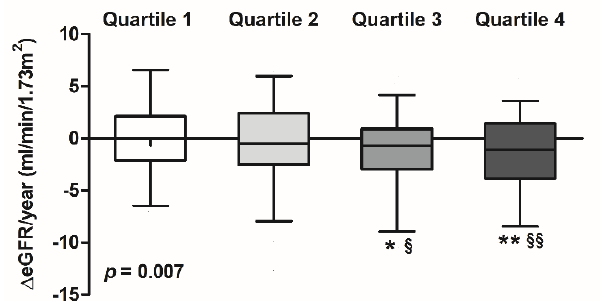
Figure 4. Decline in kidney function as measured by estimated glomerular filtration rate (eGFR) according to sex-stratified quartiles of plasma levels of group IIA secretory phospholipase A 2 (sPLA 2 -IIA). Data are shown as box plots, with the middle vertical line indicating the median, the limits of the box indicating the interquartile range, and the whiskers indicating the 5th and 95th percentiles. The p -value represents results for the Kruskal–Wallis test. * p = 0.015 versus quartile 1; ** p = 0.005 versus quartile 1; § p = 0.048 versus quartile 2; §§ p = 0.013 versus quartile 2.